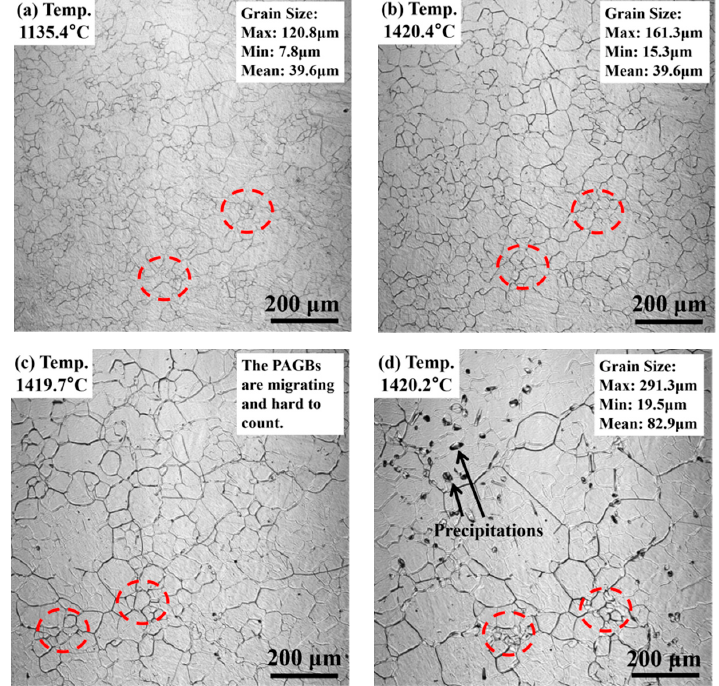
Figure 11. CLSM images of the weld metal for ( a ) heating stage, ( b ) initial stage of temperature holding stage, ( c ) temperature holding stage, ( d ) end stage of temperature holding stage.